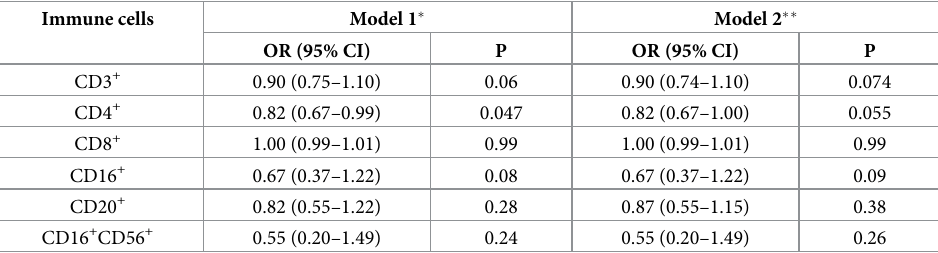
Table 4. The odds of severity affected by immune cells in patients with COVID-19 per